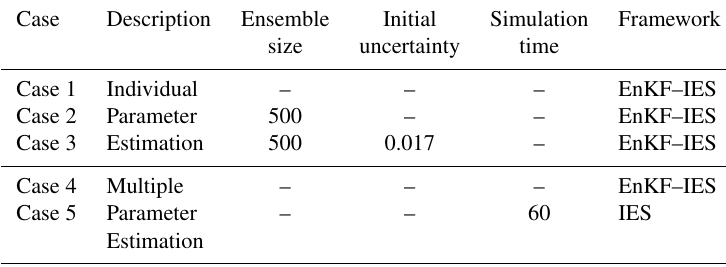
Table 3. Case summary for parameter estimation within EnKF and IES.